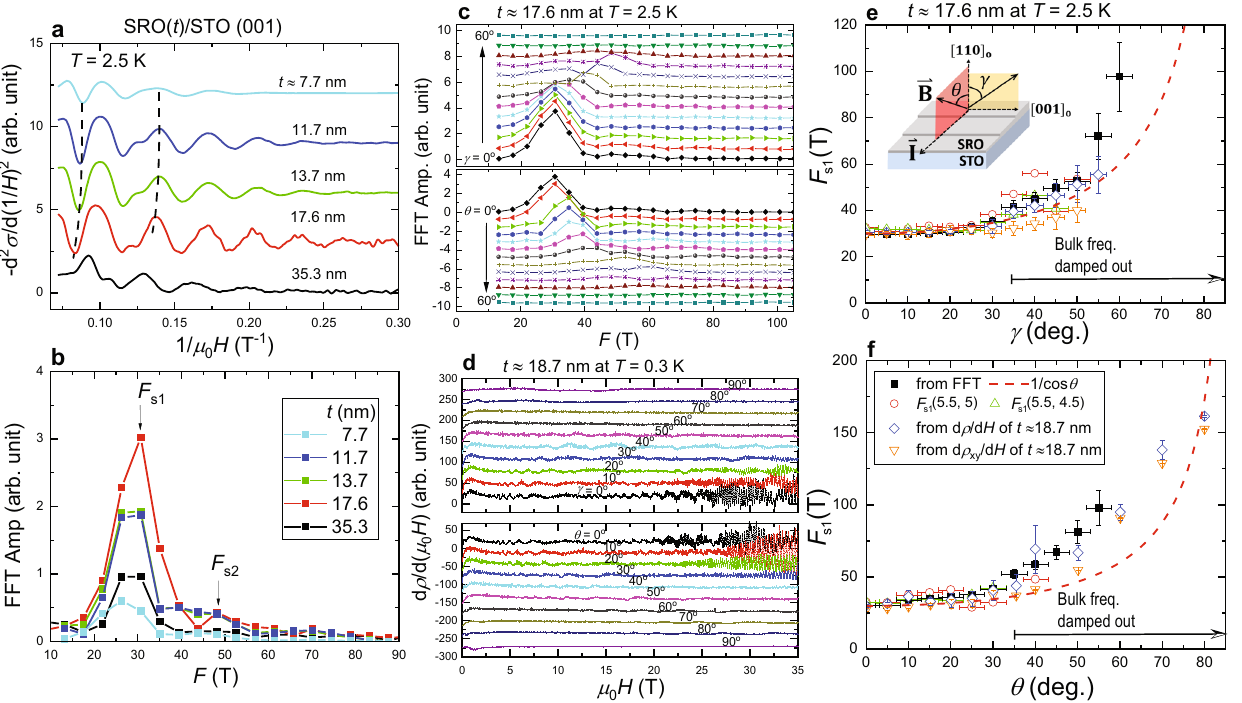
Fig. 5 The quantum oscillations of SRO fi lms in the low fi eld regime. a The − d 2 σ /d(1/ H ) 2 versus 1/ μ 0 H at T = 2.5 K for SRO fi lms with fi ve different t s ranging from about 7.7 to 35.3 nm. The curves with different t s are shifted vertically for clarity. The corresponding FFT spectra are shown in ( b ). The oscillation and FFT amplitude for F s1 appears to show a larger magnitude for t s in the range of about 10 – 20 nm. For t ≈ 17.6 nm, the angle-dependent FFT spectra for different γ and θ angles are shown in the upper panel and lower panel, respectively, in ( c ). For t ≈ 18.7 nm, the angle-dependent quantum oscillations of d ρ /d( μ 0 H ) versus μ 0 H up to 35 T were plotted in d , where the bulk frequencies of F 1 − 5 damped out at angles larger than 30 o . The curves with different θ and γ values are shifted vertically for clarity. The extracted F s1 as a function of γ and θ angles are shown in e and f , respectively. The error bars were from the standard deviations of the extracted F s1 values at each angle using various fi tting schemes. The red dashed lines represent the 1/cos θ and 1/cos γ dependence. The inset cartoon in e illustrates the orientation for the γ and θ locations in the oscillation turn out to show systematic phase Supplementary Note 4). Therefore, those smaller pockets may not contribute coherently to give observable quantum oscillations. We shifts to lower 1/ μ 0 H values as t increases, indicated by long further moved on to look for possible nonoverlapping Weyl nodes dashed lines in Fig. 5a, and an integer number of LL index ( n ) was when projecting on (110) o plane. The energy dependence of the assigned to the minimum of − d 2 σ /d(1/ H ) 25,8 . The corresponding Weyl nodes at ( k ∥ , k z ) within a window of ∣ E − E F ∣ ≤ 50 meV is shown FFT spectra for SRO fi lms with different t values are shown in Fig. in Fig. 4c, where the squares and triangles are Weyl nodes from 5b. A dominant frequency of F s1 ≈ 30 T was clearly observed, and subband pair II and subband pair III, respectively, with the red another frequency of F s2 ≈ 50 T was also observable with a much (blue) color being the chirality of + 1 ( − 1). A number of smaller FFT amplitude and also broader distribution in the FFT nonoverlapping Weyl nodes projected on k ∥ − k z plane are clearly spectra. Therefore, the quantum oscillations for μ 0 H ≤ 14 T as observed. By selecting the projected Weyl nodes at similar shown in Fig. 5a are dominated by an unusually small Fermi energies with opposite chiralities, four Weyl-node pairs are pocket associated with F s1 , which turns out to show the largest identi fi ed and shown in Fig. 4d, where the black arrows represent magnitude for t ≈ 17.6 nm. A decrease of the FFT amplitude occurs wave vectors connecting Weyl-node pairs from + 1 to − 1. The for t > 20 nm and t < 10 nm as is evident from the results in Fig. 5a. corresponding Fermi-arc lengths fall in a range from In order to further probe the Fermi pocket associated with F s1 , k 0 ≈ 0.8 – 6.5 nm − 1 . Those band calculation results support the detailed angle dependence of the quantum oscillations was presence of Fermi-arc surface states on (110) o plane, which is performed with γ -rotation and θ -rotation setups as illustrated in ! ! essential for the occurrence of WOE. However, we remark that, the inset of Fig. 5e, where B was tilted toward I and SRO [001] o due to the complex band crossings near the Fermi energy, the for θ -rotation and γ -rotation, respectively. θ and γ values are the ! Weyl node locations are highly sensitive to several parameters angles between B and the surface normal of SRO fi lms, i.e. SRO used for the band calculations. Nevertheless, nonoverlapping [110] o that appears to be the magnetic easy axis with the lowest Weyl-node pairs projected on (110) o plane are always present for coercive fi eld (see Supplementary Note 5). The resulting FFT different U values ranging from 2 to 3.4 eV (see Supplementary spectra of γ -rotation and θ -rotation for SRO fi lm with t ≈ 17.6 nm Note 3). and fi elds up to 14 T at T = 2.5 K are shown in the upper panel and lower panel, respectively, of Fig. 5c for angles ranging from 0 o to 60 o . As the angle increases from 0 o to 60 o , F s1 gradually shifts to higher frequencies for both θ -rotation and γ -rotation. Figure 5d For better revelations of the quantum oscillations in σ without shows the θ and γ dependent quantum oscillations of d ρ /d( μ 0 H ) H Þ 2 as subtracting any arti fi cial background, we plot (cid:3) d 2 σ = d ð 1 = μ 0 versus μ 0 H for SRO thin fi lm with t ≈ 18.7 nm and fi elds up to 35 T a function of 1/ μ 0 H as shown in Fig. 5a for SRO fi lms with different t s ranging from about 7.7 to 35.3 nm. The peak and valley at T = 0.3 K. For angles larger than about 30 o , the bulk frequencies